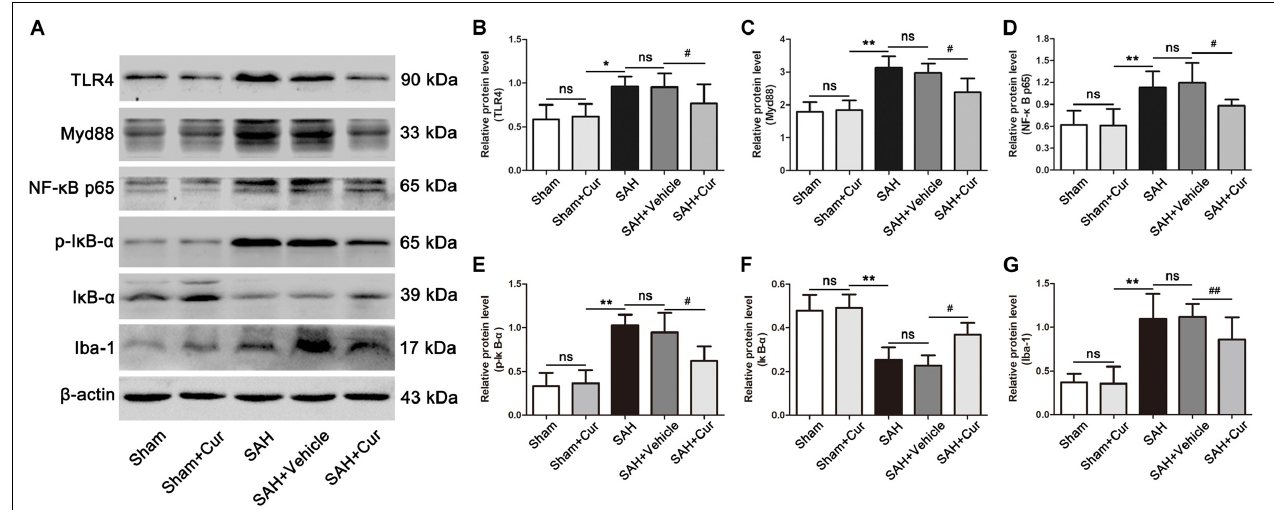
FIGURE 7 | Effects of curcumin on TLR4/Myd88/NF- κ B signaling pathway at 24 h after SAH. (A) Western blotting showed that administration of curcumin significantly reduced the protein levels of TLR4 (B) , Myd88 (C) , NF- κ B p65 (D) , p-I κ B- α (E) , and Iba-1 (G) compared with the SAH + vehicle group. In contrast, curcumin treatment elevated the reduced level of I κ B- α (F) . The quantitative data are the mean ± SD ( n = 5, each; ∗ p < 0.05, ∗∗ p < 0.01 vs. Sham + Cur group; # p < 0.05, ## p < 0.01 vs. SAH + Vehicle group; ns p > 0.05).